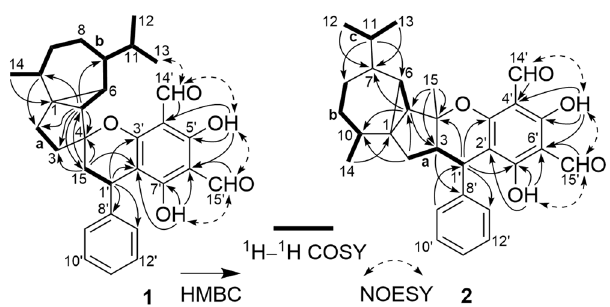
Figure 2. Selected 1 H– 1 H COSY, HMBC, and NOESY correlations of 1 and 2